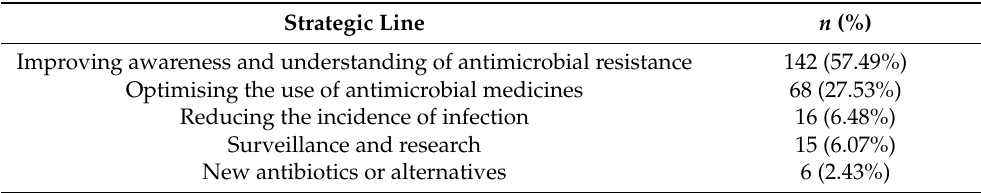
Table 6. Purpose of included infographics according to the five strategic lines set out in the World Health Organization Global Action Plan on Antimicrobial Resistance.